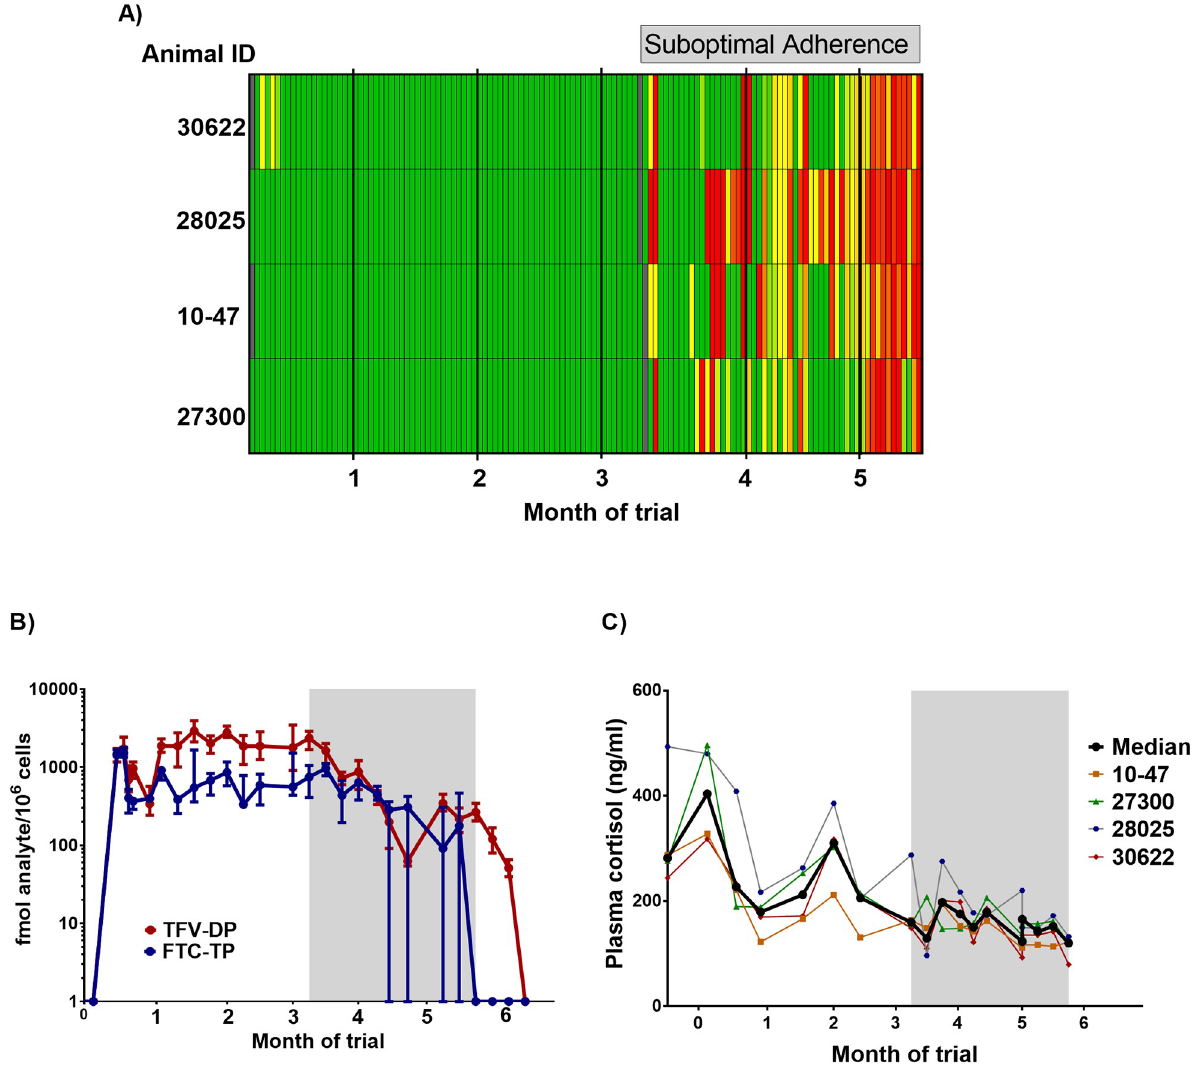
Fig 5. Adherence during extended treatment. A) Adherence heat map . Macaques (n = 4) were administered daily doses of FTC/TAF in a blended drug delivery mixture. Days of drug administration is denoted in columns (one box = one day) and the four animals in the rows. Colors in the heat map reflect 100% of the dose eaten (green), 50% of dose eaten (yellow), and 0% of dose eaten (red). Days of drug administration by gavage are not included in the adherence map. Day of spleen biopsy are indicated with gray boxes. B) Concentrations of FTC-TP and TFV-DP in PBMCs . FTC-TP and TFV-DP were stable during the first three months coinciding with high adherence to daily oral FTC/TAF. The period of suboptimal adherence is highlighted by gray bar. C) Plasma Cortisol levels . The gray area denotes the period of suboptimal